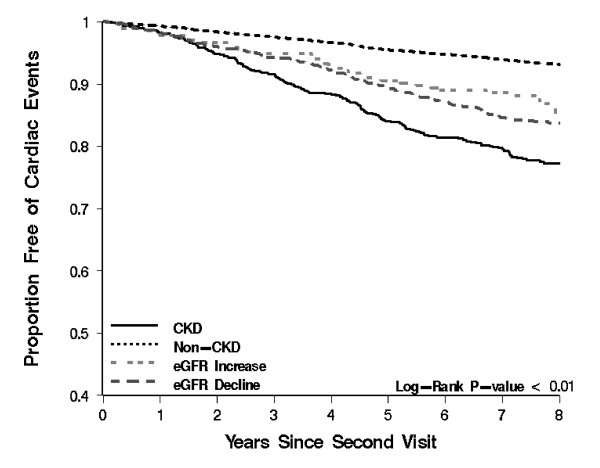
Kaplan-Meier curves presenting the relationship between kidney function groups and Cardiac outcomes.